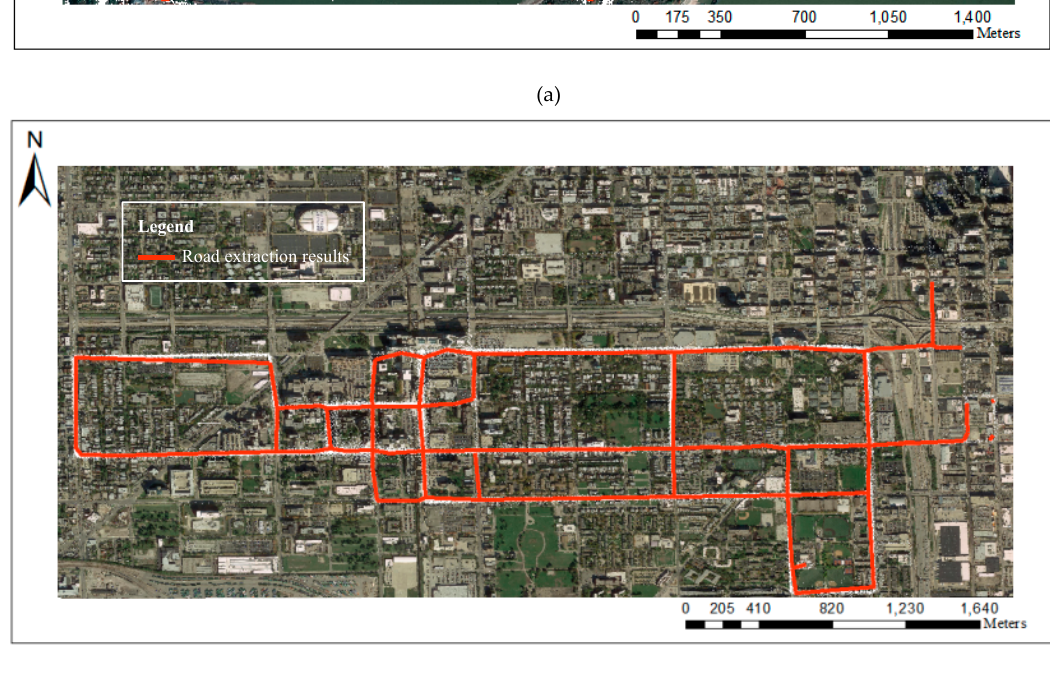
Figure 17. The final road network extraction results: ( a ) results of road network detection in Wuhan; ( b ) results of road network detection in Chicago.